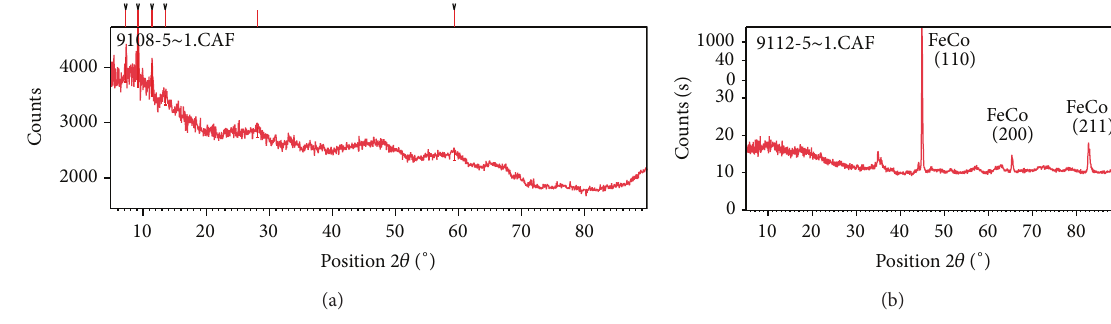
Figure 1: XRD patterns of W3 sample in (a) as synthesized state and (b) annealed at 550 ∘ C for 20 minutes.